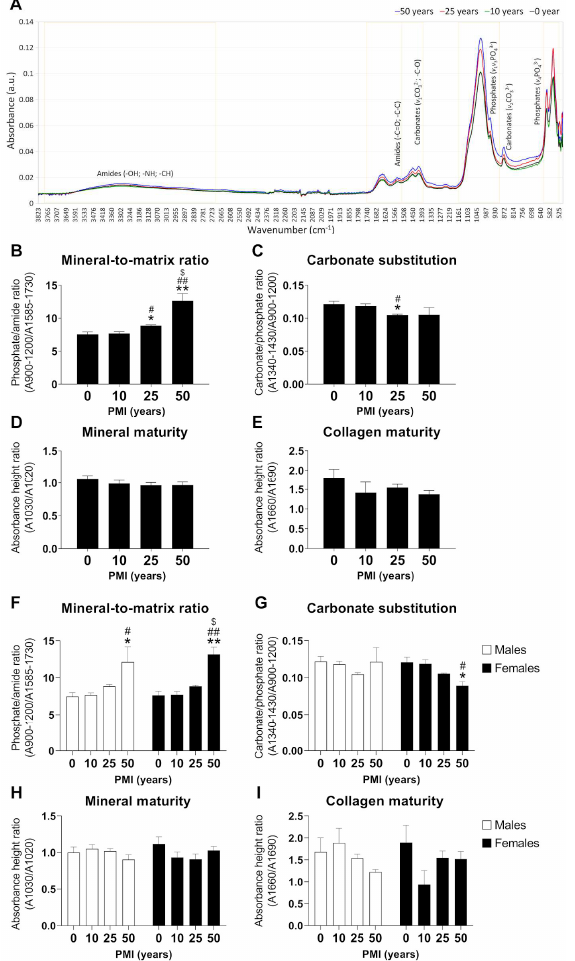
Figure 2. Analysis of tooth composition by ATR-FTIR to determine PMI. ( A ): Mean values of the ATR-FTIR spectra from each PMI group (0, 10, 25 and 50 years). ( B ): Effect of PMI on mineral-to-matrix ratio. ( C ): Effect of PMI on carbonate-to-phosphate ratio. ( D ): Effect of PMI on mineral maturity. ( E ): Effect of PMI on collagen maturity. ( F ): Effect of PMI on mineral-to-matrix ratio by gender. ( G ): Effect of PMI on carbonate-to-phosphate ratio by gender. ( H ): Effect of PMI on mineral maturity by gender. ( I ): Effect on collagen maturity by gender. Histograms represent means ± SD ( n = 10). */** p < 0.05/0.01 versus control group; #/## p < 0.05/0.01 versus 10-year group; $ p < 0.05 versus 25-year group.